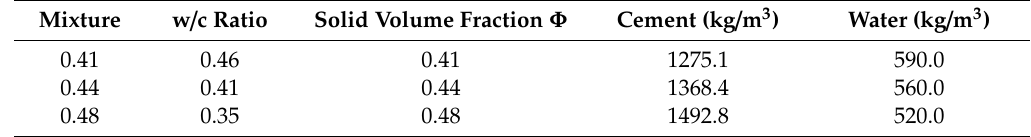
Table 1. Cement paste